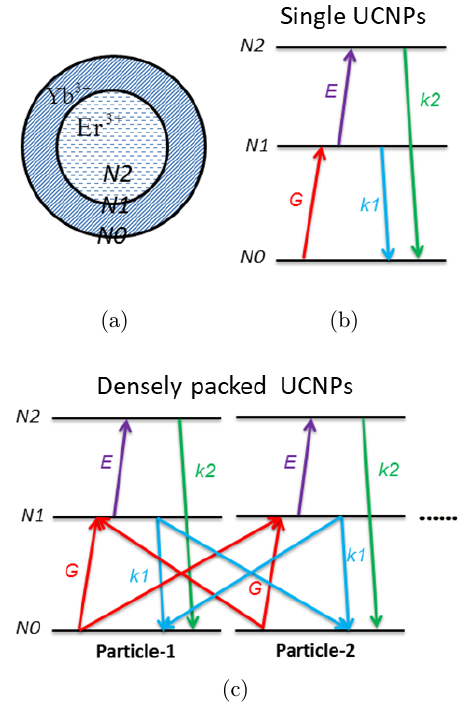
Fig. 5. Scheme of the electron state distribution of the UCNP (a), and the excitation and emission process for a single (b) and densely packed UCNPs (c).